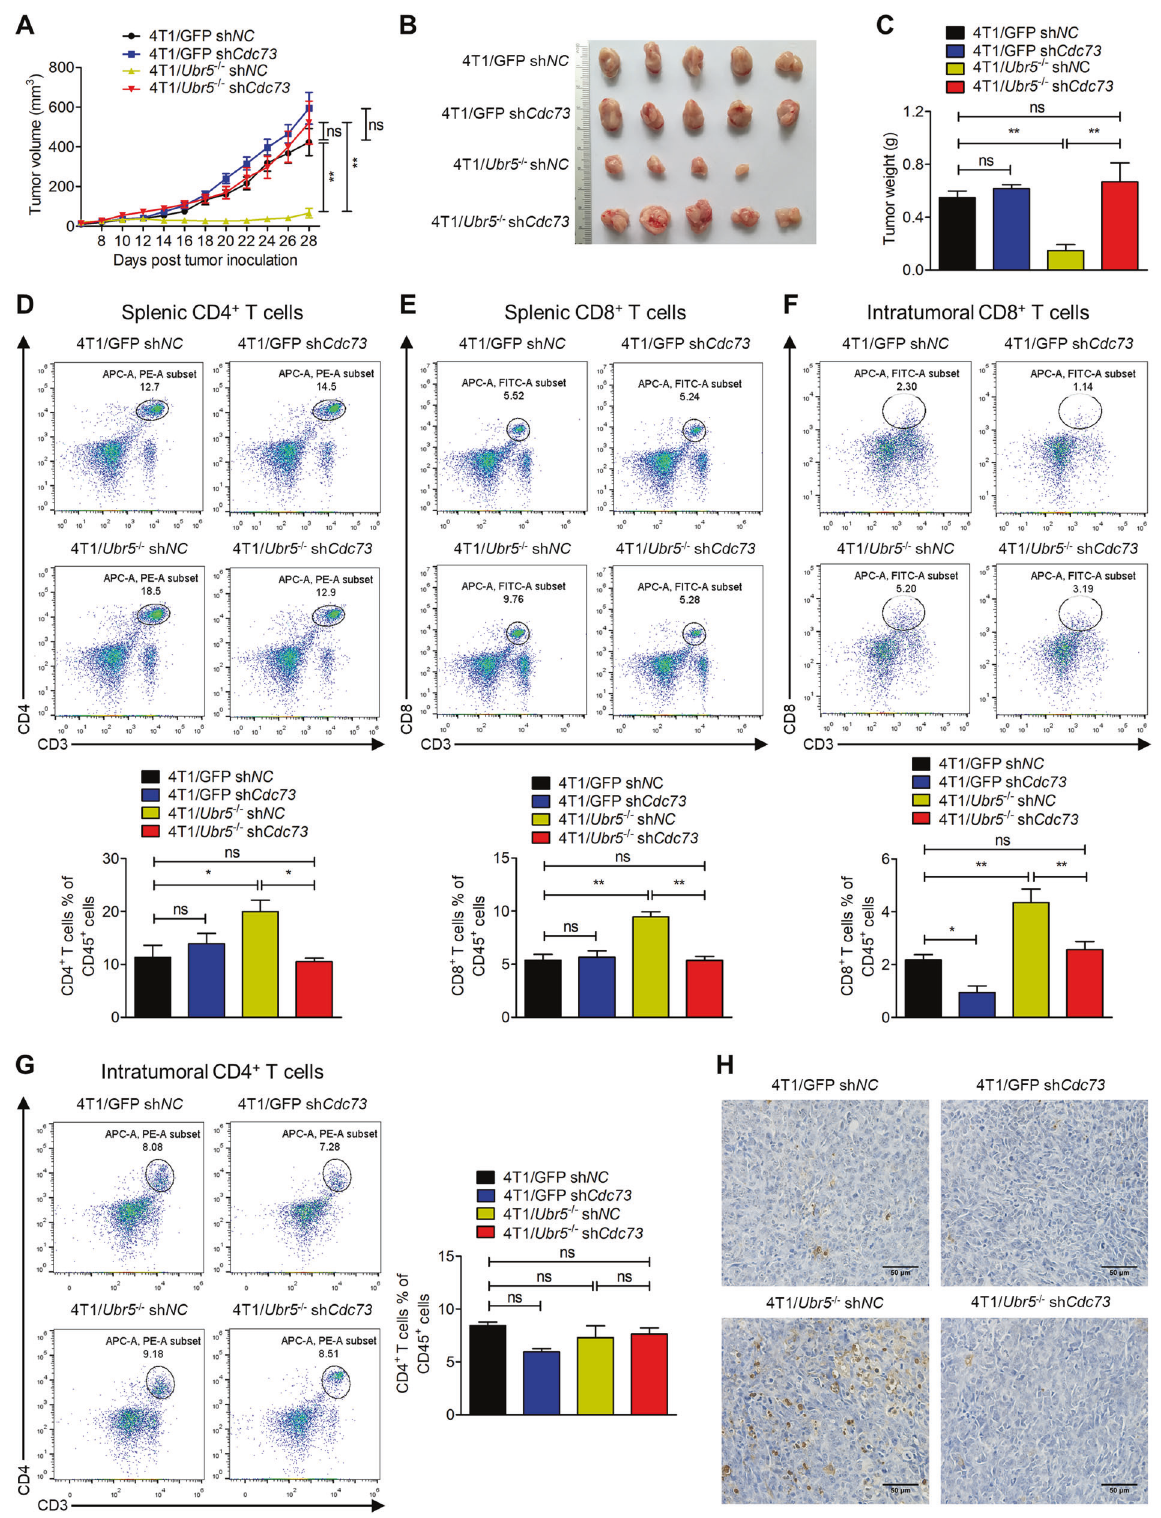
Fig. 3 CDC73 antagonizes UBR5 ’ s tumorigenic and immunoregulatory activities. A Tumor size was measured every 2 days in BALB/c mice injected with 5 × 10 5 4T1/GFP sh NC , 4T1/GFP sh Cdc73 , 4T1/ Ubr5 − / − sh NC , and 4T1/ Ubr5 − / − sh Cdc73 cells into the mammary fat pad, respectively, and the tumor-bearing mice were sacri fi ced on day 28 after injection ( n = 5). Representative tumor images ( B ) were documented and tumor weight ( C ) was measured on day 28. Representative FACS images and quanti fi cation of splenic CD4 + T cells ( D ) and splenic CD8 + T cells ( E ), as well as intratumoral CD8 + T cells ( F ) and intratumoral CD4 + T cells ( G ) were analyzed on day 28 ( n = 3). H Representative images of TUNEL staining of the tumor sections analyzed on day 28. Data were shown as mean ± SEM; ns not signi fi cant; * p < 0.05; ** p < 0.01.